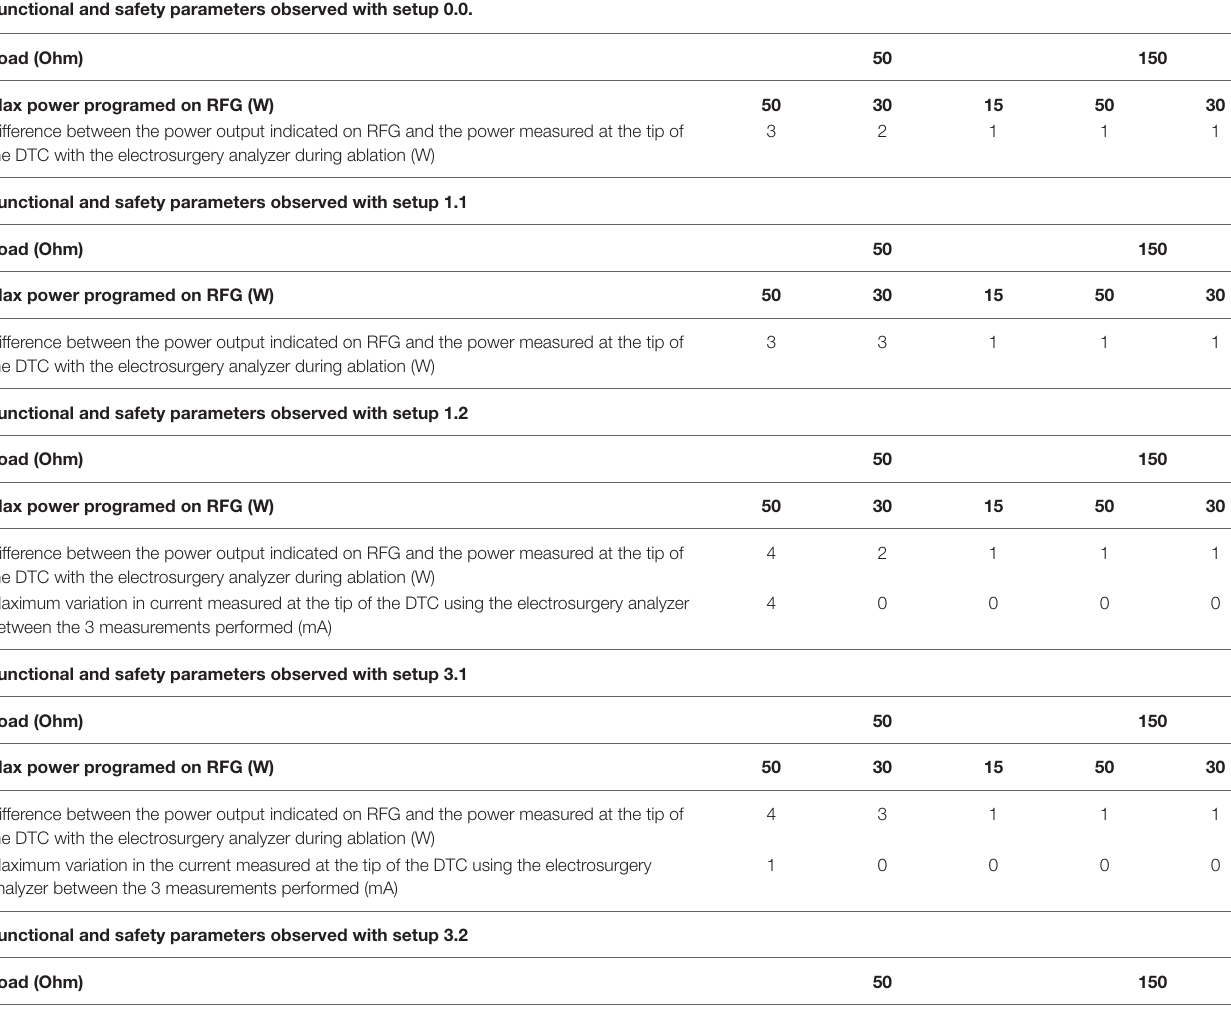
TABLE 1 | Functional and safety parameters with different